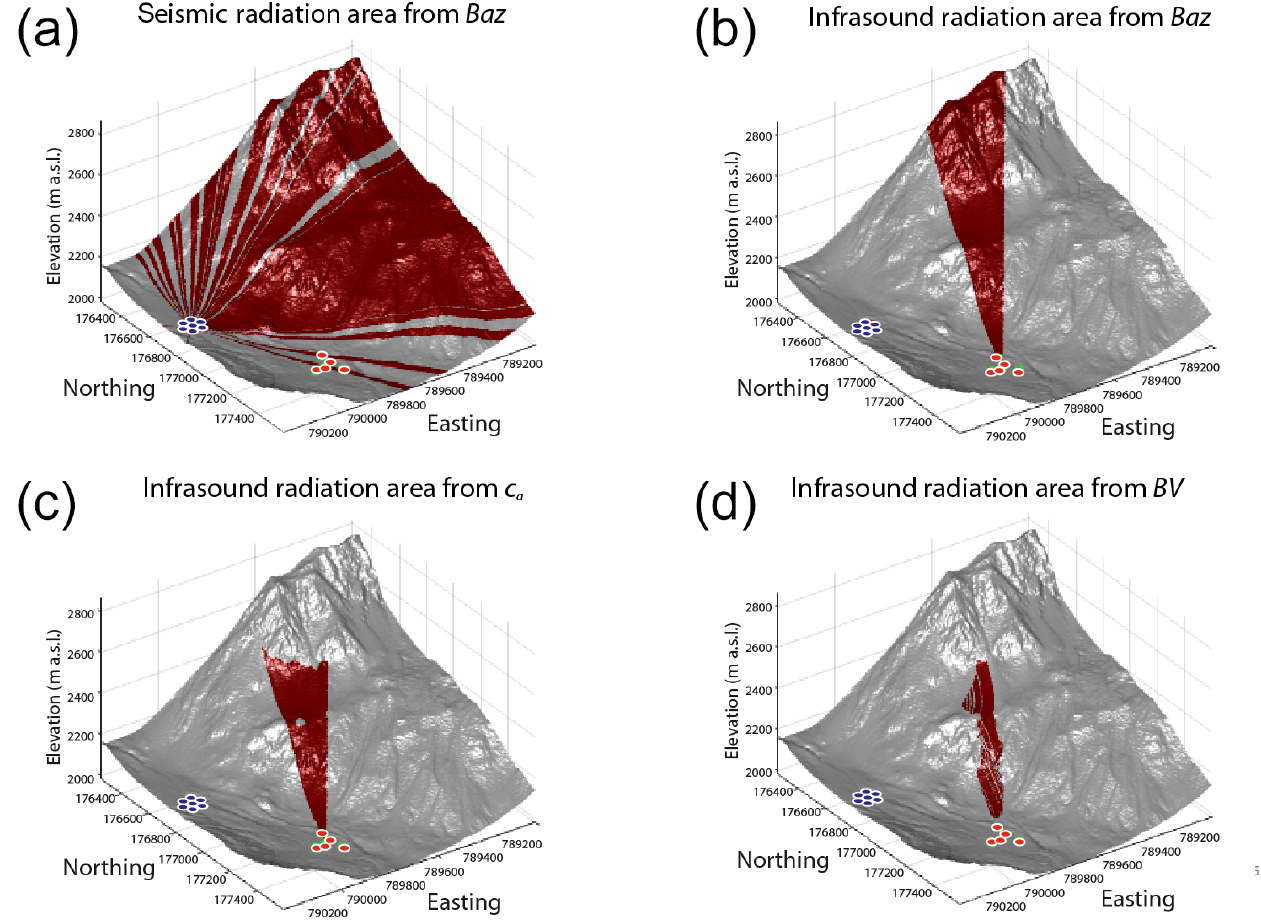
Figure 7. Possible radiation areas (dark red) of seismic and infrasound energy, obtained from seismic back-azimuth (Baz s , a ), infrasound back-azimuth (Baz i , b ), infrasound apparent velocity ( c a , c ) and the combination of infrasound back-azimuth and apparent velocity (BV, d ). The position of the seismic array is shown by blue circles, while the position of the infrasound array is shown by red